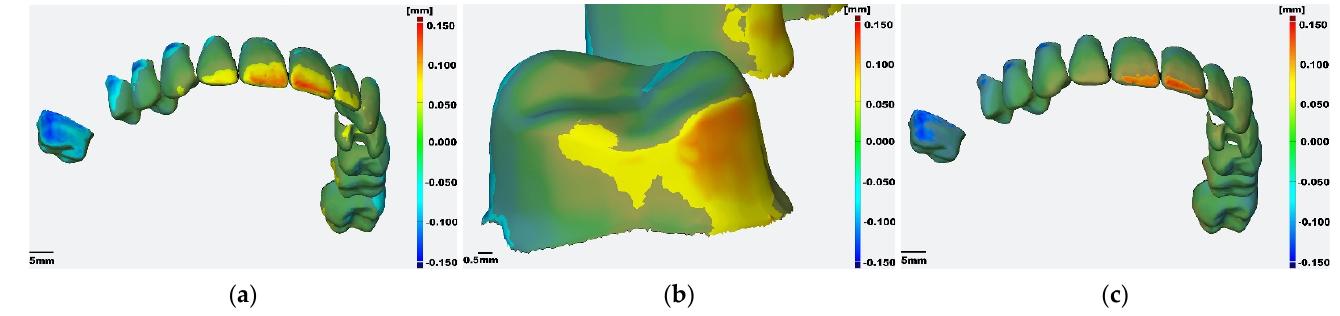
Figure 4. Excluded areas depending on the included quantiles [Scale ± 150 µm]: ( a ) 10/90 quantile (highlighted area = excluded); ( b ) 5/95 quantile (highlighted area = excluded); ( c ) 1/99 (highlighted area = excluded).